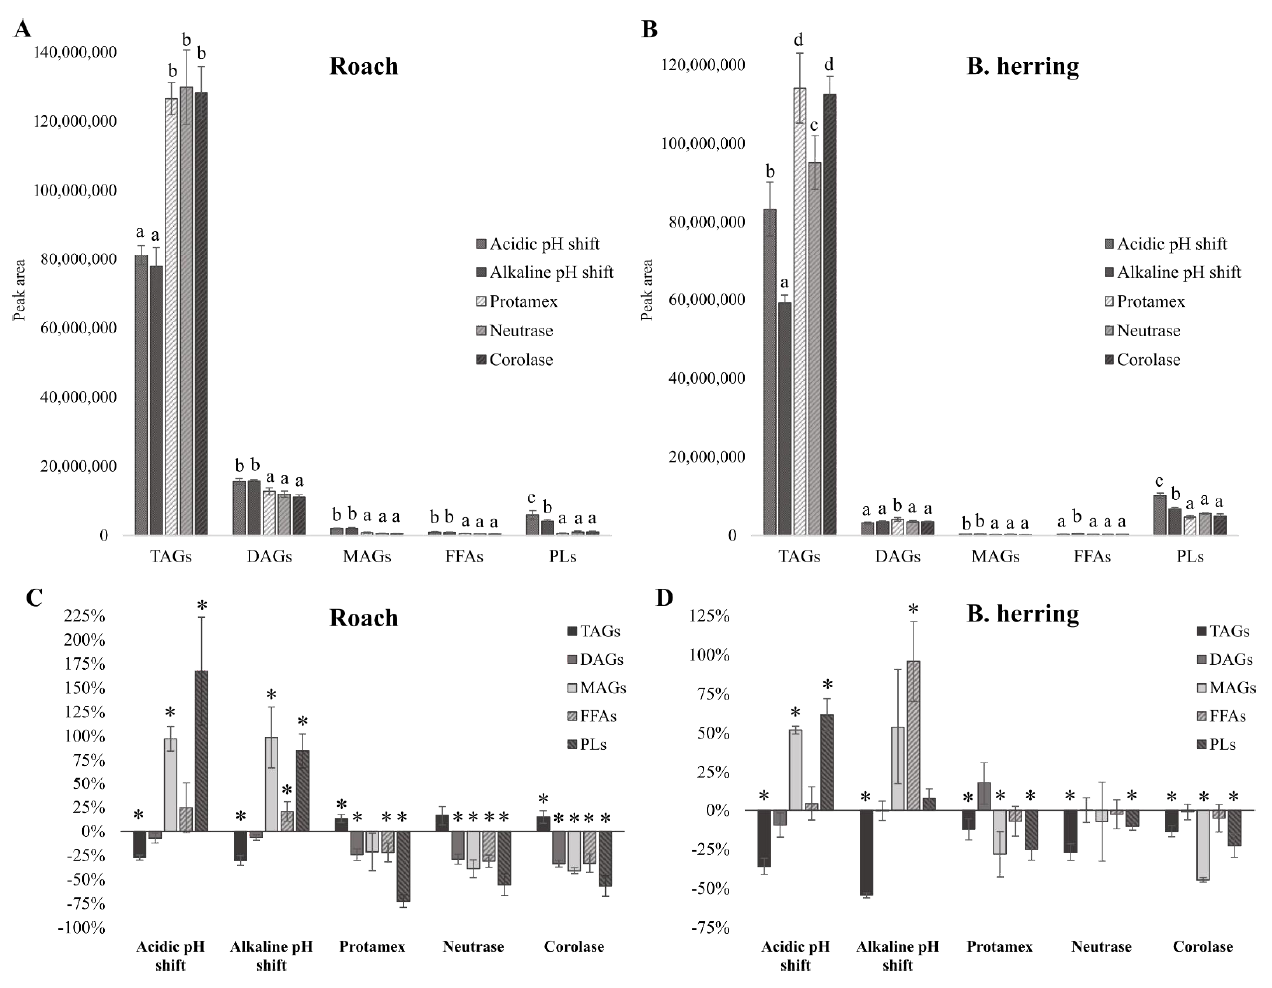
Figure 1. Sum peak areas of triacylglycerols (TAGs), diacylglycerols (DAGs), monoacylglycerols (MAGs), free fatty acids (FFAs), and phospholipids (PLs) in protein isolates and hydrolysates of roach ( A ) and B. herring ( B ), and relative changes in lipid class peak areas in lipids of protein isolates and hydrolysates compared with the fish raw material ( C and D ). Different letters or an asterisk (*) within each lipid class indicate a statistically significant difference ( p < 0.05). Peak areas in an equal content of lipids were determined using liquid chromatography mass spectrometry.